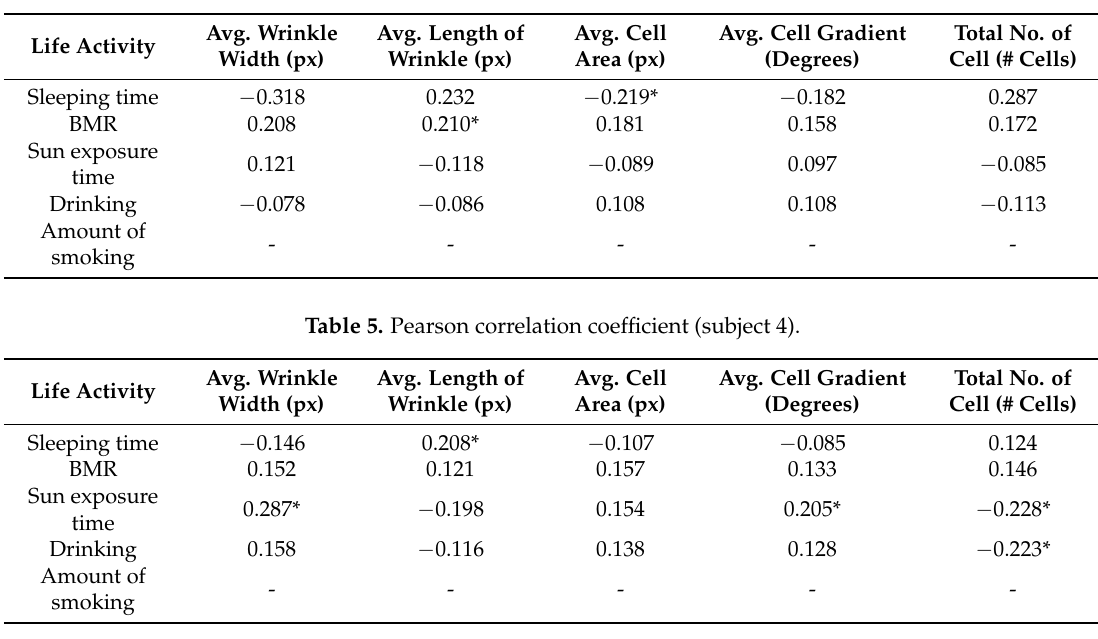
Table 4. Pearson correlation coefficient (subject 3).